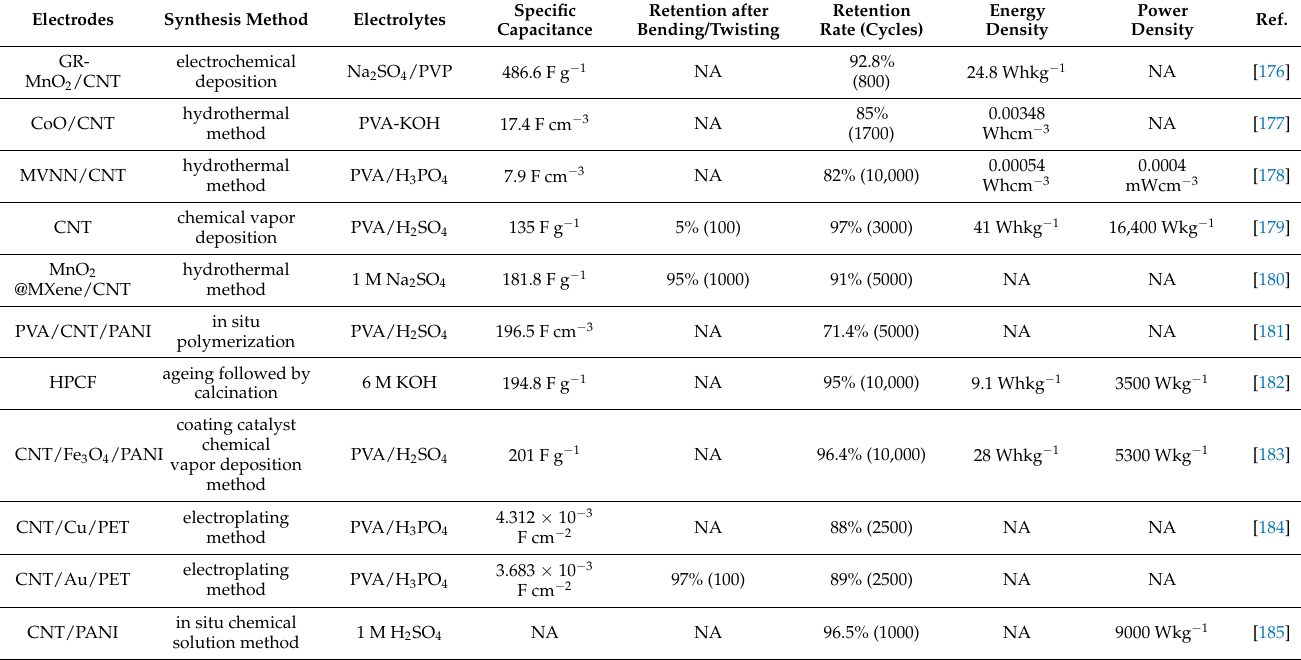
Table 1. CNT nanocomposites as electrode materials for FSC